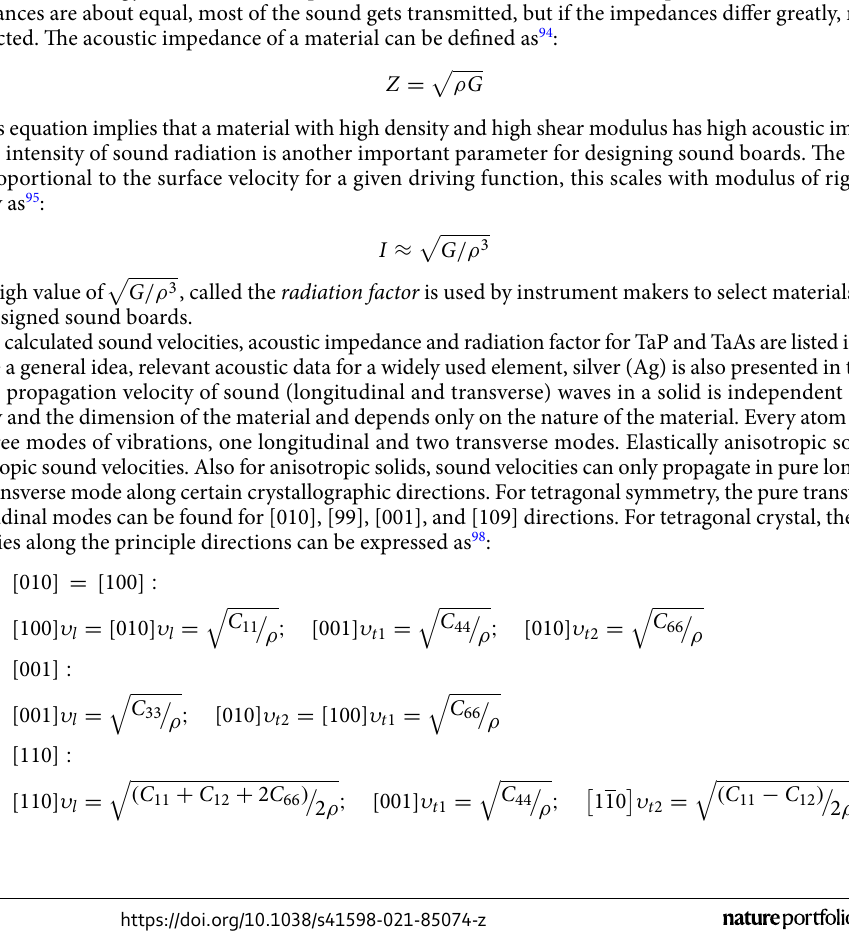
Table 6. Density ρ (g/cm 3 ), transverse velocity ν t (ms −1 ), longitudinal velocity ν l (ms −1 ), average elastic wave velocity ν a (ms −1 ), acoustic impedance Z (Rayl) and radiation factor compounds.